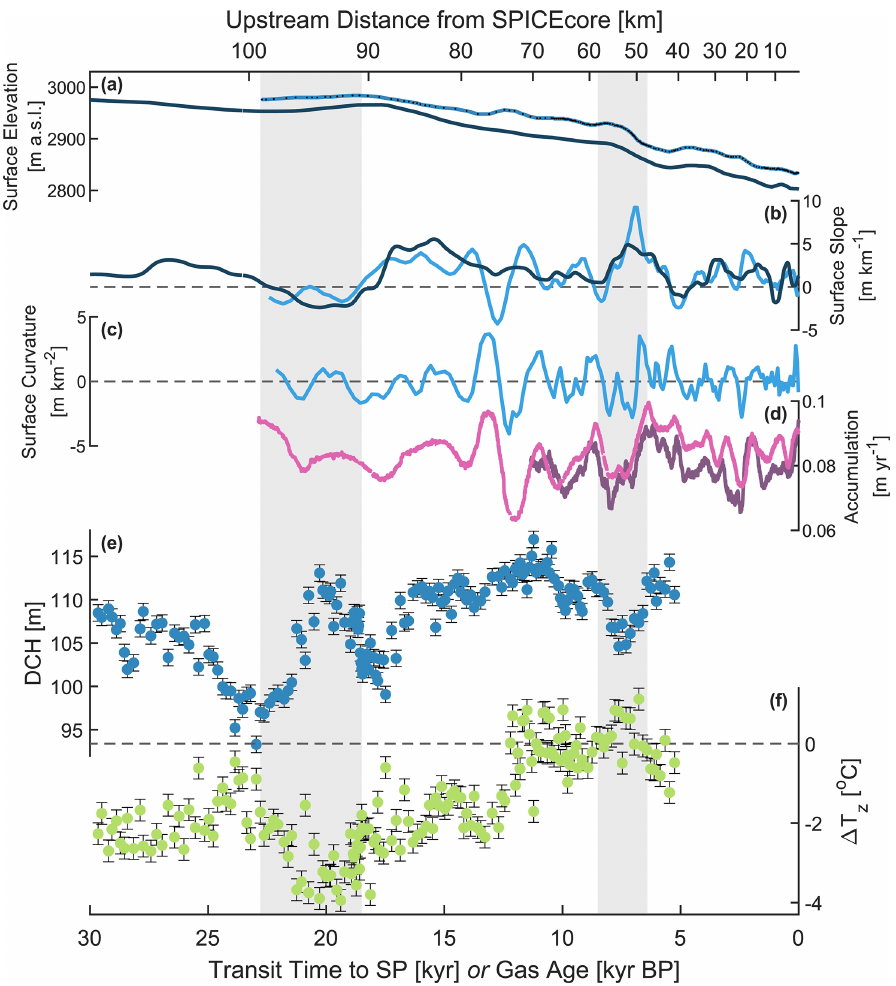
Figure 3. From top to bottom: (a) surface elevation profile (meters above sea level) along the flowline upstream of the SPICEcore site. The light blue line corresponds to snowmobile-mounted GPS data from Lilien et al. (2018). The dark blue line corresponds to PolarGAP airborne radar data from Jordan et al. (2018). The gridded radar data were interpolated to the flowline using inverse-distance-weighted interpolation. (b) Surface slope (first derivative) and (c) curvature (second derivative) of the elevation profiles, calculated in the direction of the flowline. Colors are as in (a) . Curvature of the PolarGAP data is not shown due to the coarser spatial resolution of this dataset. (d) The pink line shows the accumulation rate along the flowline upstream of the SPICEcore site from Lilien et al. (2018). The purple line shows the SPICEcore accumulation rate derived from strain-corrected annual layer thicknesses (Winski et al., 2019). (e) Firn diffusive column height and (f) temperature difference calculated from our isotope data. Upstream data in panels (a) – (d) are plotted on the bottom x axis as functions of the transit time to the SPICEcore site based on the “mean” scenario in Fudge et al. (2020). The corresponding distances are shown on the top x axis. SPICEcore data in panels (d) – (f) are plotted as functions of age on the SPC19 chronology. Grey shading highlights the changes in DCH and (cid:49)T z between 23 and 18.5kyrBP and between 8.5 and 6.5kyrBP, which are discussed in the